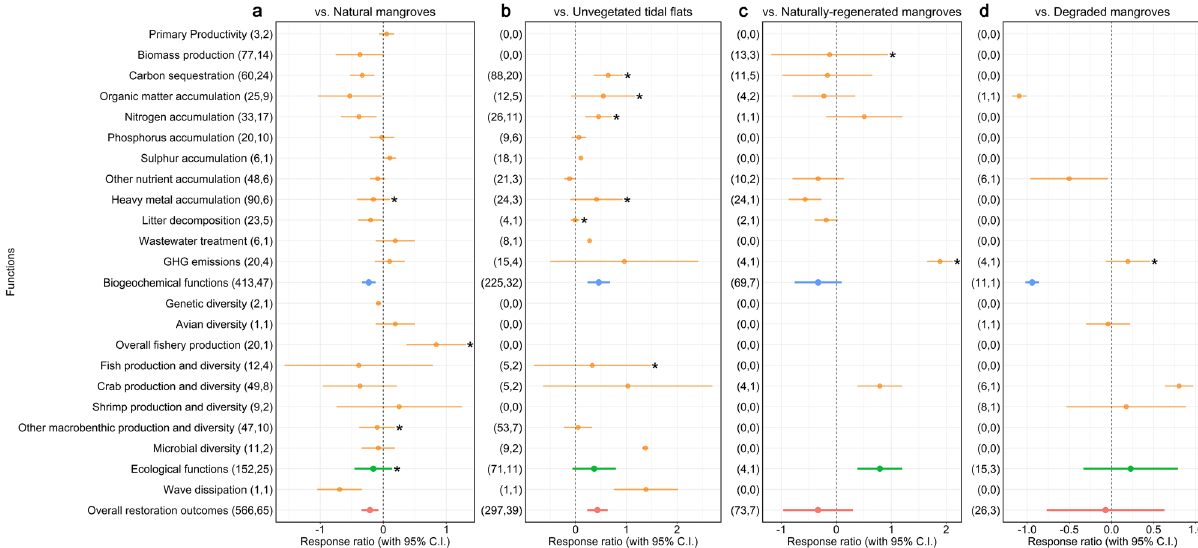
Fig. 2 Mean effect size for different functions. Panel a restored mangroves vs. natural mangroves, b restored mangroves vs. unvegetated tidal fl ats, c restored mangroves vs. naturally regenerated mangroves and d restored mangroves vs. degraded mangroves. Bars around the means denote 95% CIs. If a bar falls in the positive side and does not intersect with zero we interpret that the restored mangrove provides this speci fi c function at a higher level than the comparative basis, and the opposite if it falls in the negative side of the forest plot. The fi rst and second numbers in parentheses indicate, respectively, the number of observations and the number of studies included in each calculation. Bars with asterisks denote functions for which publication bias was detected. For the de fi nitions of individual functions and aggregated categories refer to Supplementary Table 1. The overall restoration outcome for each comparative base was estimated as the pooled effect size of all individual functions. Source data are provided as a Source Data fi le.